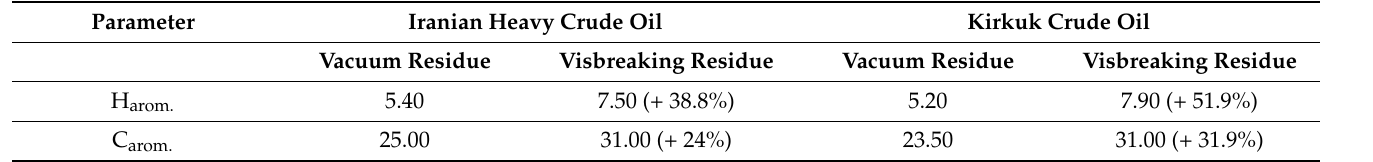
Table 2. Measurement of H arom. and C arom. using NMR of residues from Iranian heavy crude oil and Kirkuk crude oil